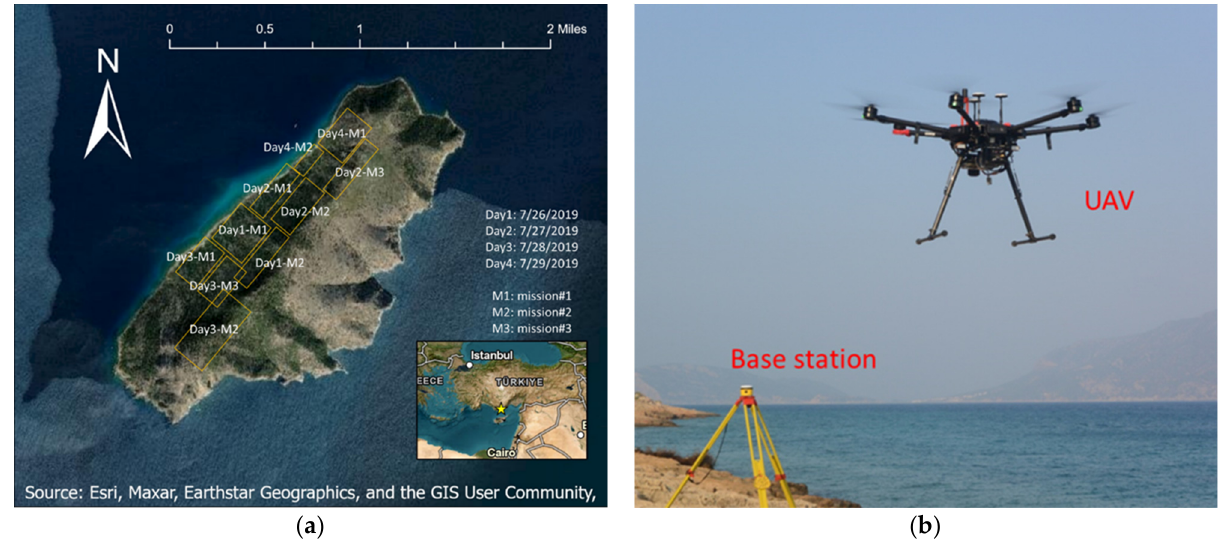
Figure 3. Illustrations of ( a ) mission information (yellow asterisk shows the study site) and the ( b ) used UAV and base station along the west coast of Dana Island.